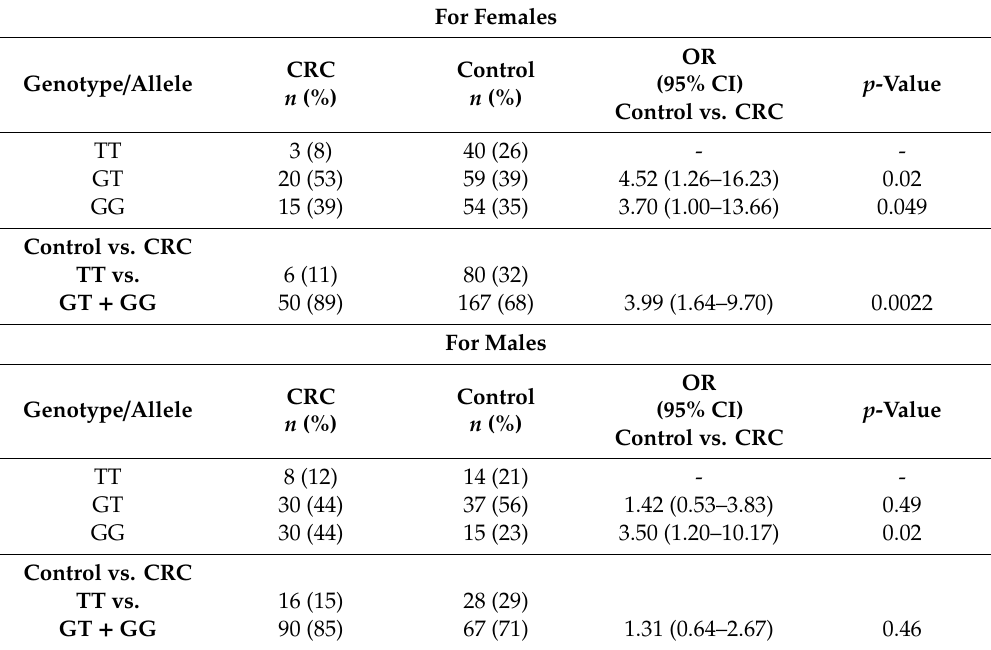
Genotype and allele frequencies of CYP27B1 SNP rs10877012 polymorphism in